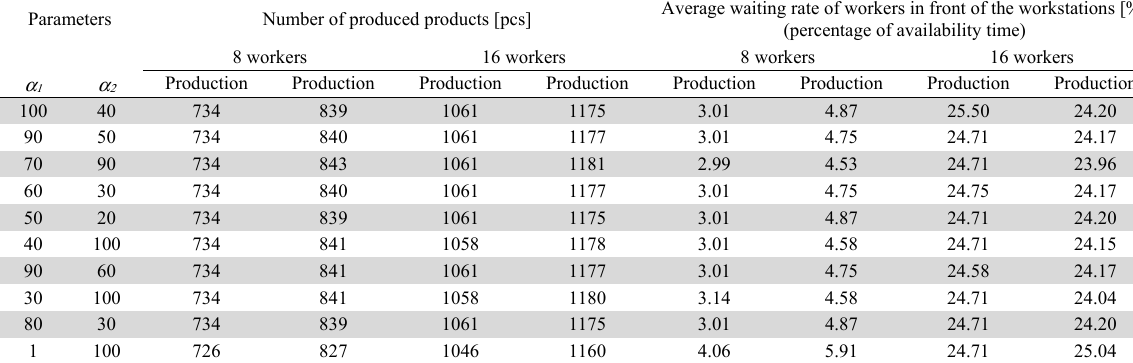
Some numerical results of simulation studies focused on 𝛼 parameters Parameters Number of produced products [pcs]